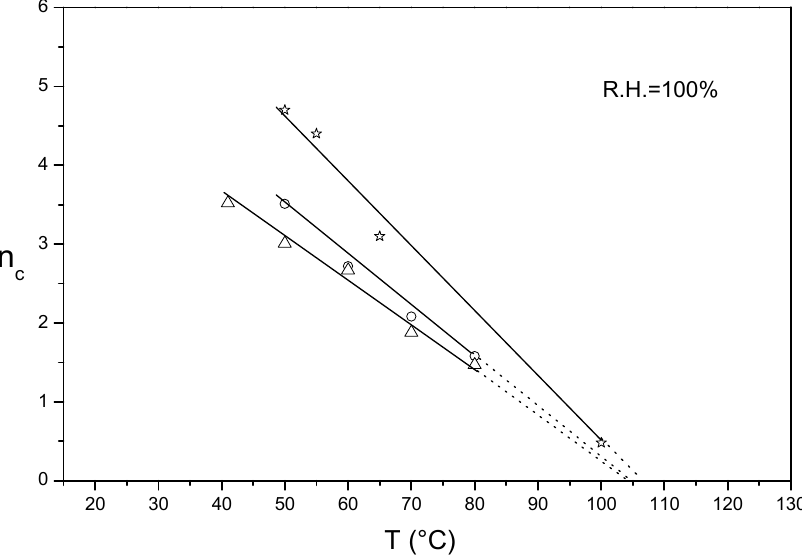
Figure 4. n c / T plot of un-crystallized Aquivion ® 790 ( empty triangles ), Aquivion ® 830 ( empty circles ) and Nafion ® 1100 ( empty stars ).